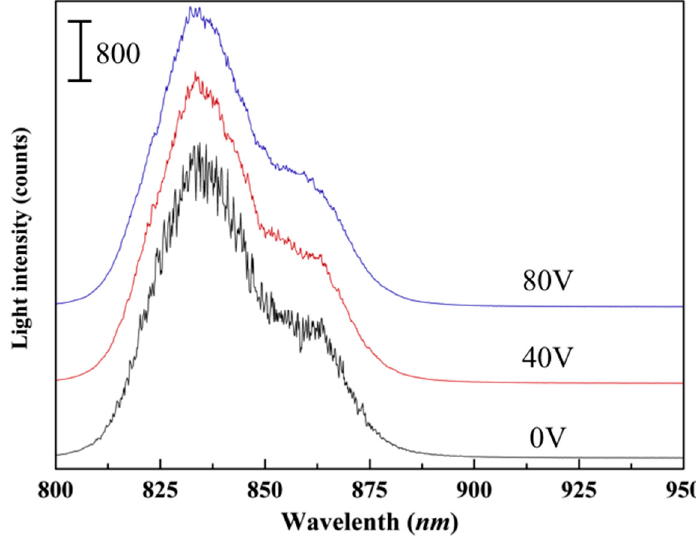
Figure 11. The experimental output of spectrum with the driven voltage of 0 V, 40 V, and 80 V.